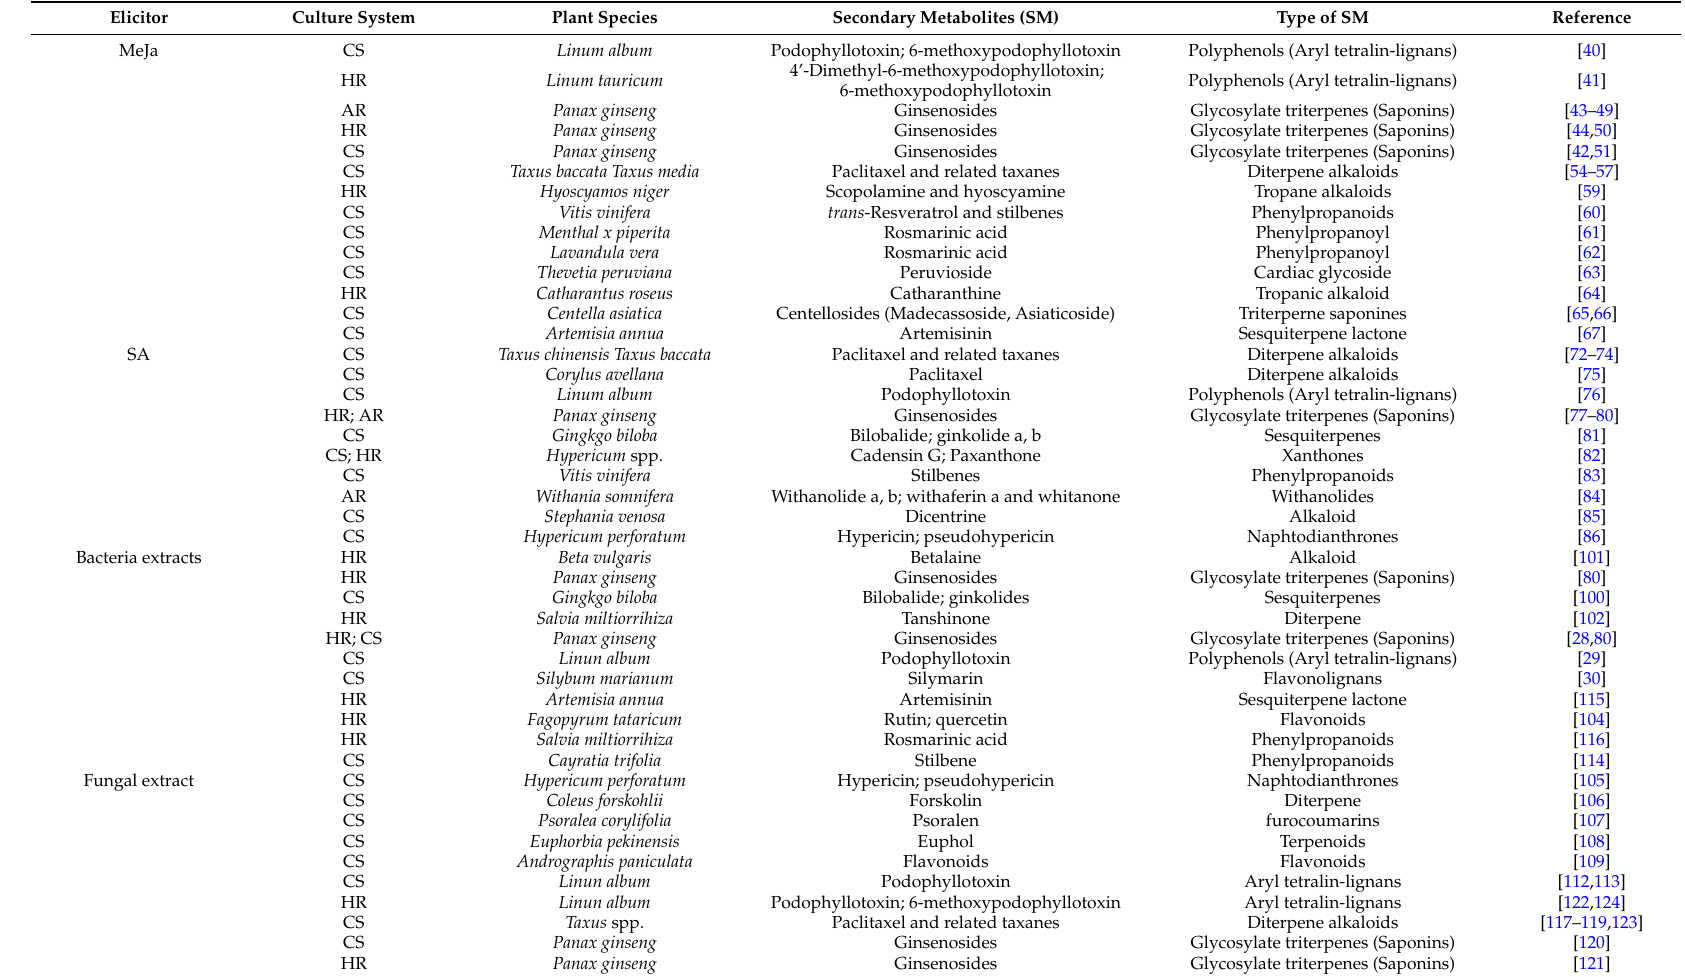
Table 1. Effect of biotic elicitors on secondary metabolite production in plant in vitro